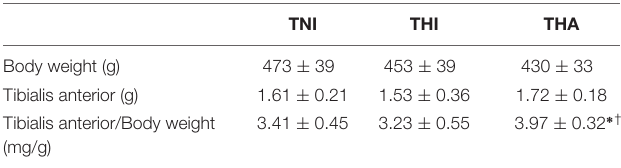
TABLE 1 | Tibialis anterior and body